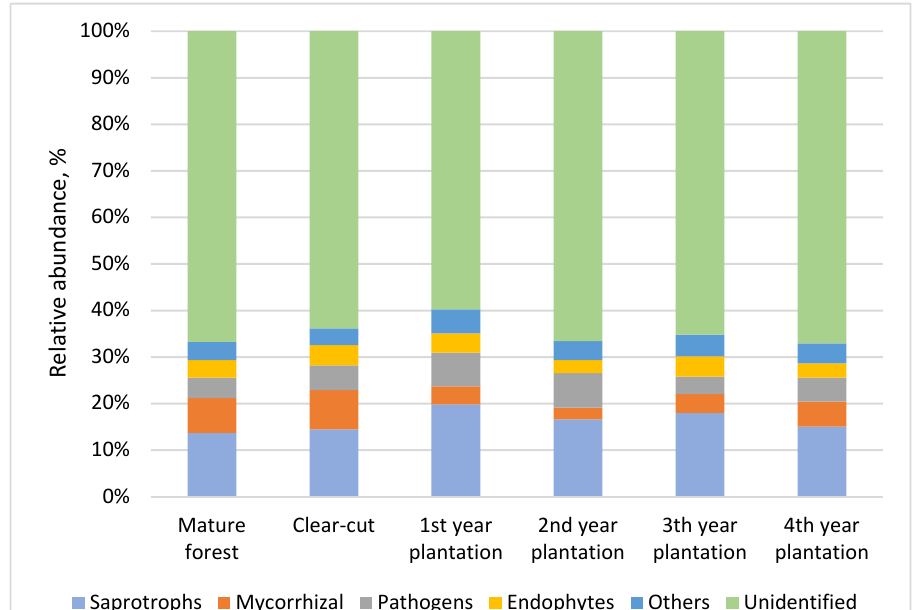
stands, clear-cuts, and reforested 1st–4th year Pinus sylvestris L. plantations.